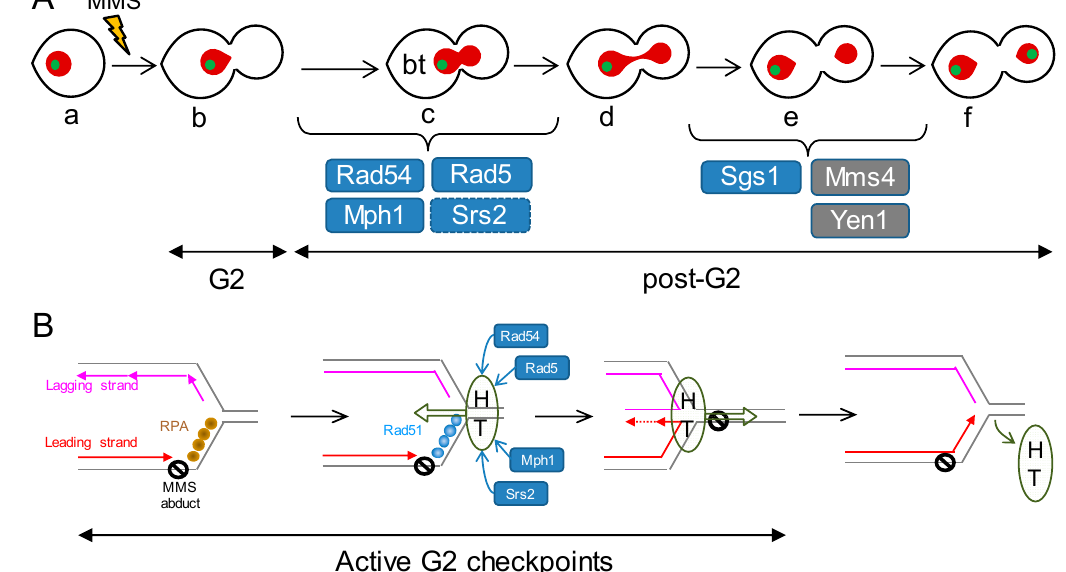
Figure 7. Models of how Mph1 might cooperate with other HR helicases/translocases during replication stress in order to avoid later chromosome segregation problems. ( A ) Putative steps during the mitotic progression in which the studied factors may exert a safeguard role after replication stress. MMS would cause SRFs and activation of G2 checkpoints, rendering the prototypical mononucleated dumbbell cell (b). HR-dependent bypass/repair of the SRFs would turn off the G2 checkpoint, allowing cells to enter anaphase and attempt sister chromatid segregation (c–f). Removal of HR-dependent JMs is a must to achieve proper segregation (f). Rad54 and Rad5 are thus essential for bypassing/repairing the SRFs, switching off the G2 checkpoint, and entering an apparently normal anaphase. Mph1 safeguard function also resides at the G2-anaphase transition, yet to a lesser extent. Srs2 backs up Mph1 here, whereas Mph1 backs up Rad5 and Rad54. Pathways that deal with HJs (one kind of JMs), namely Mms4-Mus81, Yen1 and Sgs1, appear especially important for cXIIr segregation (e–f transition). Blue boxes depict helicases/translocases, whereas grey boxes depict SSEs. ( B ) Model of co-operation among the studied factors in the context of the SRF bypass through the fork regression mechanism. An MMS adduct on the parental template for the leading strand would cause loss of replication synchrony at the affected RF. The exposed ssDNA ahead of the leading strand block would be coated by RPA, triggering a G2 block and favouring repair by HR. Rad51 would replace RPA shortly afterwards. Fork regression could be executed through the co-ordinated actions of HR factors together with helicases and translocases. For instance, a helicase-translocase complex (HT) could translocate de RF backwards (Rad5, Rad54 and Mph1). Rad51 would promote rapid annealing of the nascent strands, a likely step needed to nucleate and sustain the fork regression reaction. Srs2 and Mph1 would remove Rad51 while fork regression is in progress, favouring the formation of the cross-shaped intermediate that serves as template for extension of the leading strand. Once this step has been accomplished, the same (or part of the) helicase-translocase complex would shift direction, translocating the regressed RF into a proper RF, thus bypassing the lesion on the parental strand and turning off the G2 checkpoint.